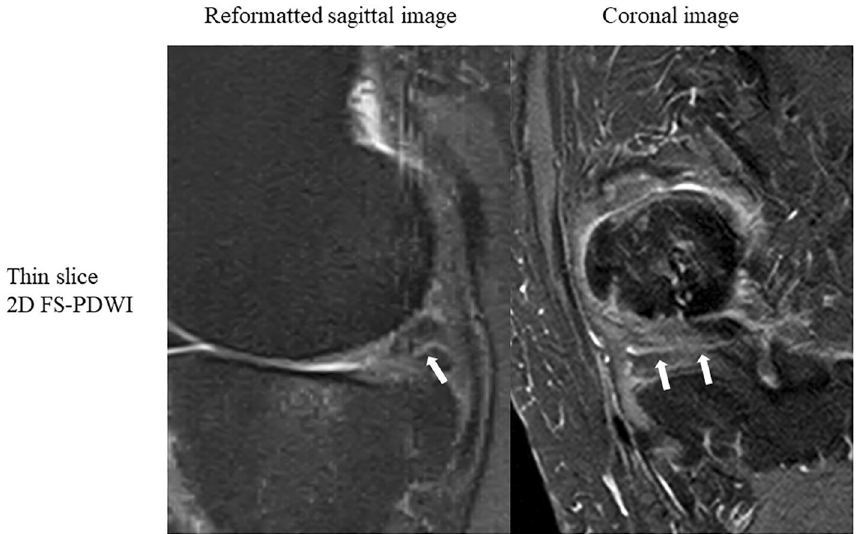
Figure 3. A 58-year-old woman with horizontal tear of the posterior horn of the medial meniscus (arrows). The flow artifact of the popliteal artery on sagittal image covers the posterior horn, making it slightly difficult to see, but the horizontal tear is clearly delineated. 2D FS-PDWI indicates 2-dimensional fat saturated-proton density weighted